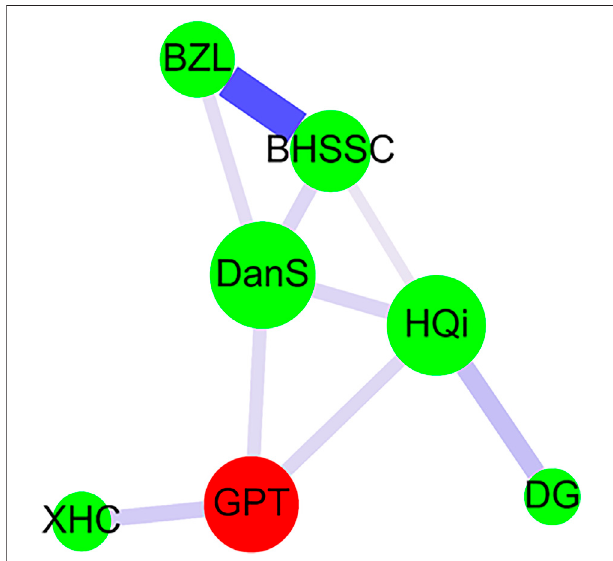
FIGURE 3 | CHM network analysis in AA patients. Herbal formula is shown as the red circle, and single herb is expressed as the green circle. The circle size indicates prescription frequency of the CHM. The linesize and color signify the support value and the lift value between paired CHM products, respectively. The thicker and darker connection line shows the stronger strength of connection between the paired CHM products.